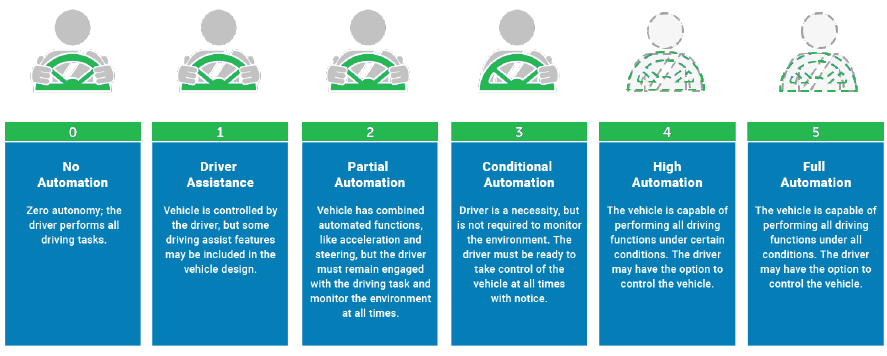
Figure 1. Vehicle automation